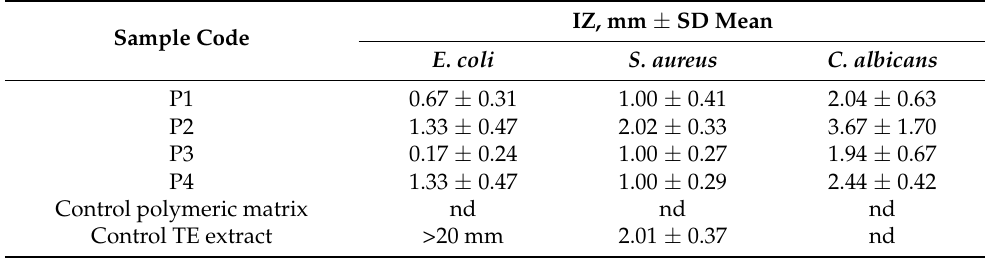
Table 4. Inhibition zones for analyzed